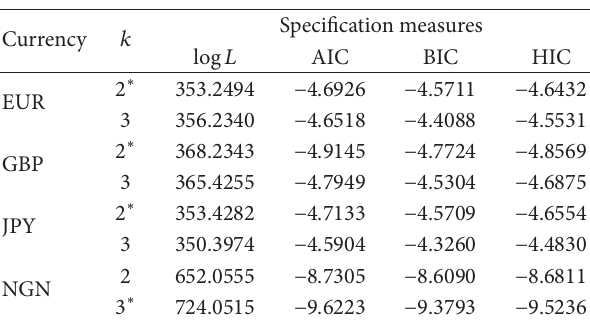
Table 1: Comparison of specification measures for selected curren-